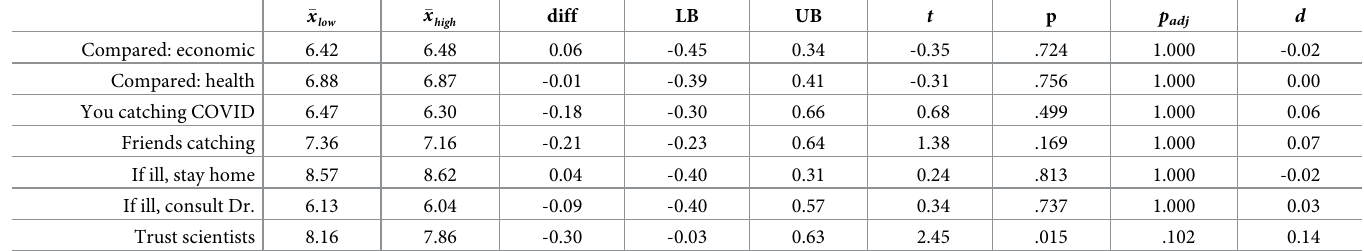
Table 7. Statistics comparing the responses on the attitude questions for those given the response alternative focused on low values and those on high values. The t and p values used the normed data (i.e., ranked and the inverse normal function applied) due to distributions being skewed. � x low